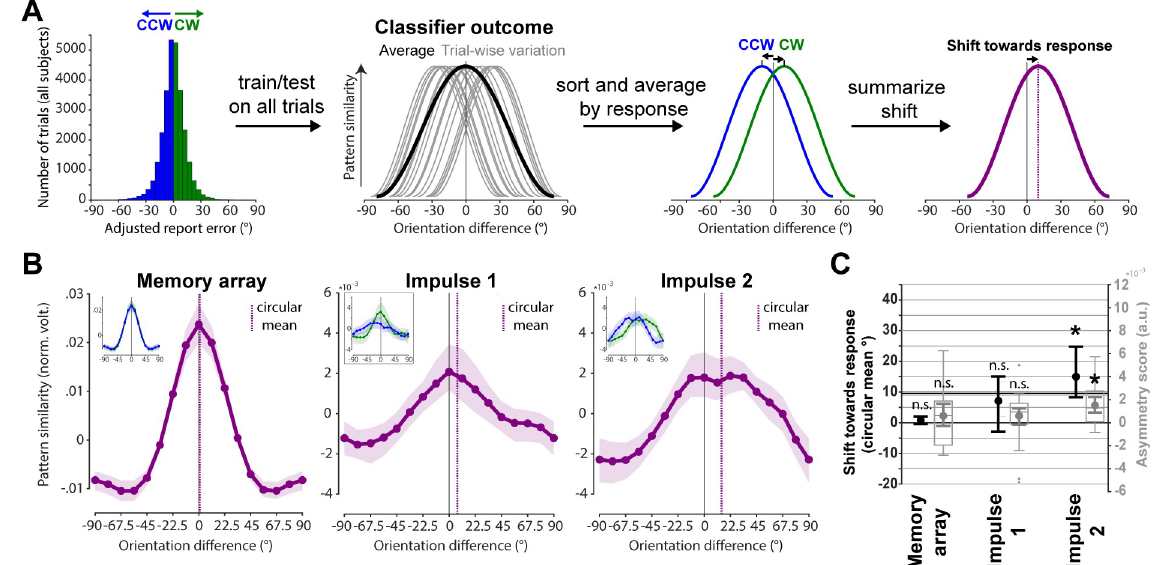
Fig 6. Response-dependent averaging of trial-wise similarity profiles demonstrates drift. Schematic and results. (A) Testing for shift towards response by averaging trial-wise similarity profiles by CCW/CW responses. (B) Results of schematised approach in (A). Orientation similarity profiles averaged by response such that a rightward shift reflects a shift towards the response (purple) at each event. Purple vertical lines show circular means of the similarity profiles. Insets show orientation similarity profiles for CCW (blue) and CW (green) responses separately. Error shadings are 95% CI of the mean. (C) Group-level (circular mean) and participant-level (asymmetry score) shifts towards the response of each response-dependent similarity profile are shown in black and grey, respectively. Error bars are 95% CI of the mean. The blue line and shading indicates the mean and 95% CI of the absolute, bias-adjusted behavioural response deviation (approximately 10 degrees). Data available at osf.io/cn8zf. a.u., arbitrary units; CCW, counterclockwise; CW, clockwise; norm. volt., normalised; n.s., not significant.